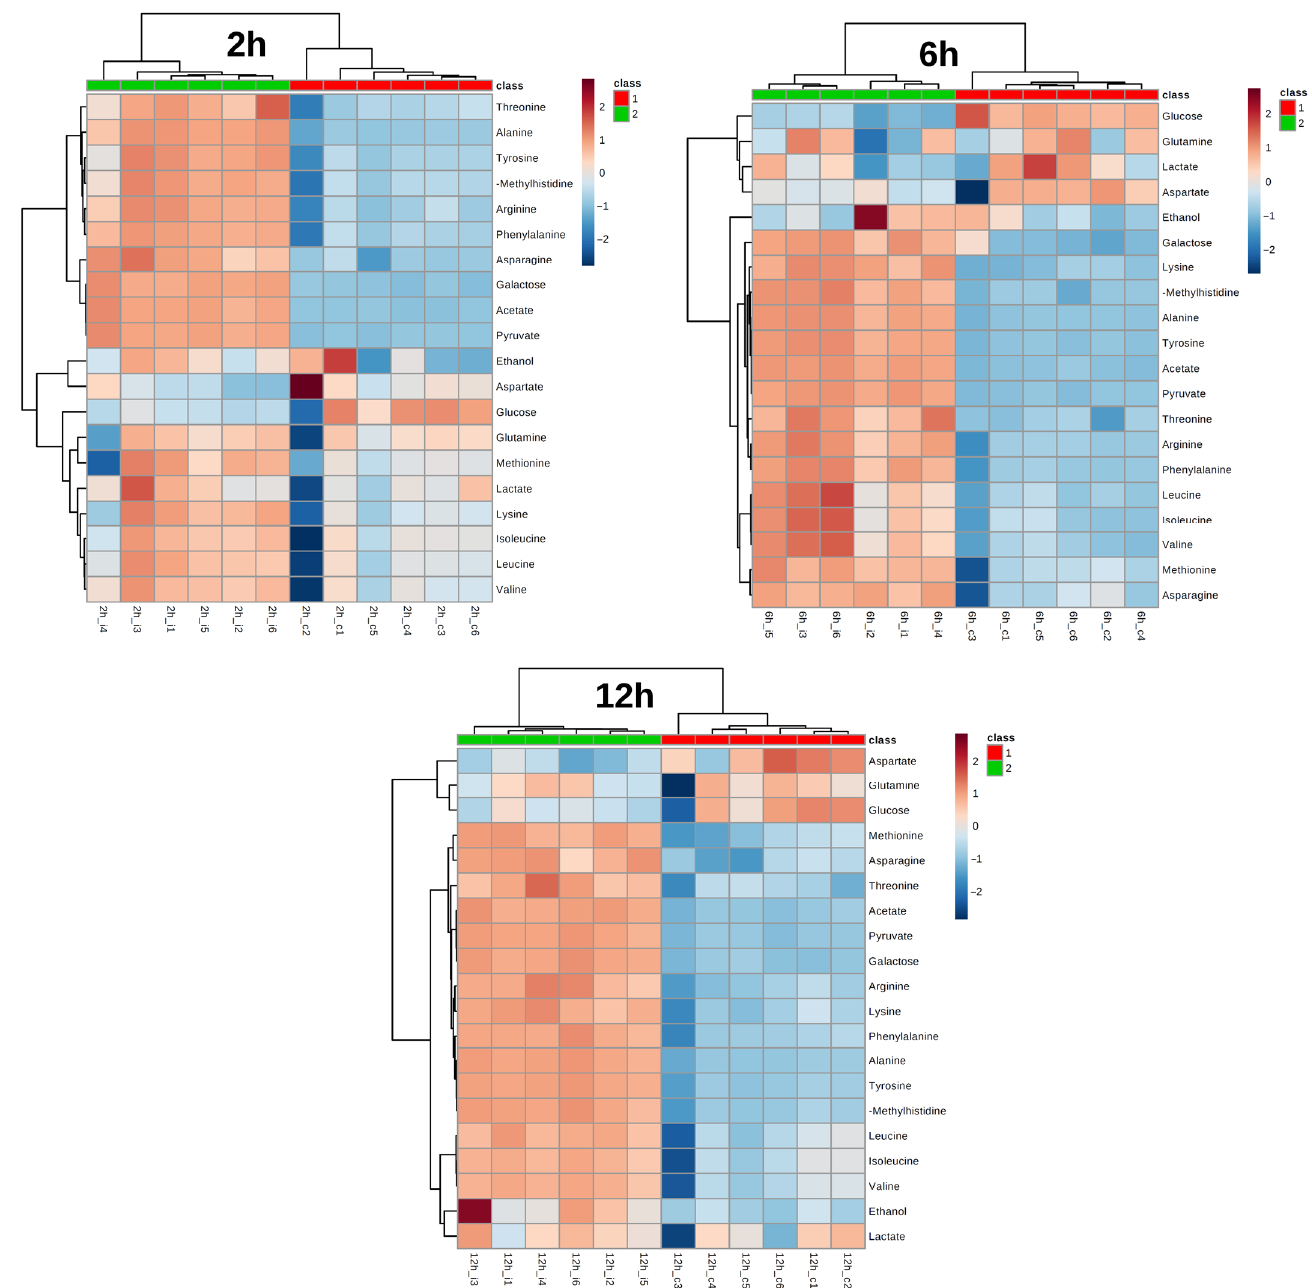
Figure 4. Levels of affected metabolite by MAYV infection process. The identified metabolites that are affected are evaluated by relative concentration for each specific time point. In 2 hpi (upper left) infected cells (label 2, green) are observed to have higher levels of most metabolites, except for aspartate, which level is not affected by infection, and glucose, which is more consumed in infected cells. In 6 hpi (upper right) infected cells are seen to consume more glucose (similarly to 2 hpi), lactate, and aspartate. Other identified metabolites are at higher levels in infected cells. In 12 hpi (bottom) infected cells follow the same behavior as in the 6 hpi time point, but levels are different between control and infected cells. Also, lactate is not observed to have different levels in control and infected cells.